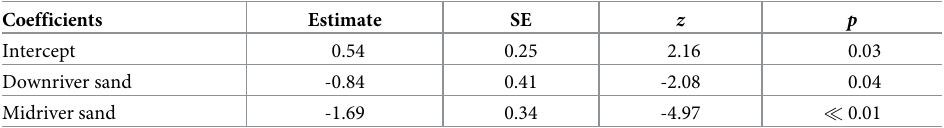
Table 4. Summary of GLM for model g 7 predicting presence, including parameter estimates (log-transformed), standard errors, z values and p values. The intercept represents downriver seagrass. Model g 7 explained 9.3% of the null